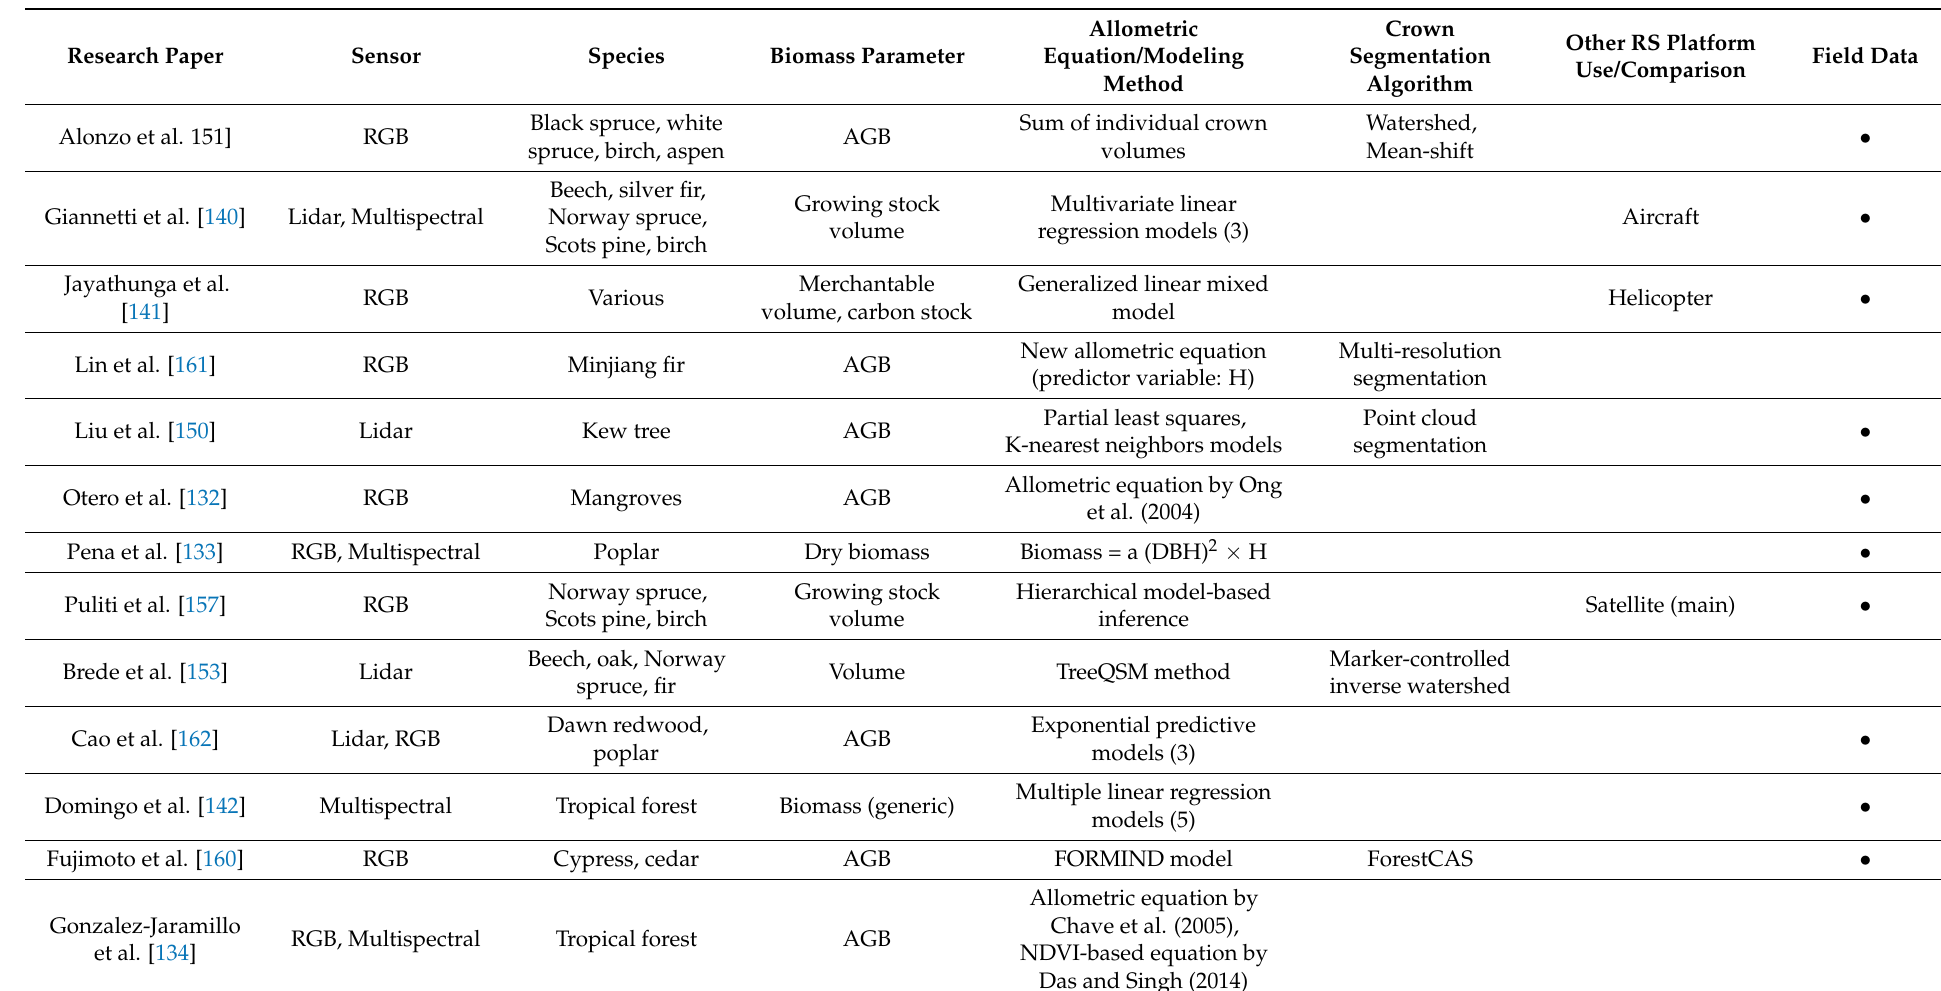
Table 3. Reviewed studies for aboveground biomass (AGB)/volume estimation topic: sensor, tree species, biomass parameter, allometric equation/modeling method, segmentation algorithm, other RS platforms use/comparison, and field data